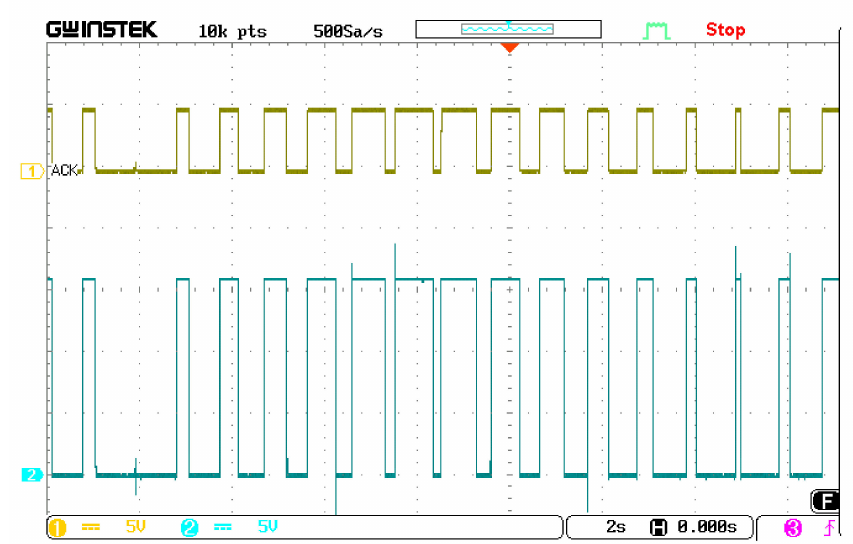
Figure 3. (Cha-1) The PWM digital output, and (Cha-2) the translated signal by the level shifter board. To mount the encoder on the motor, a 3D printed coupling was designed in the SOLIDWORKS “2020, Wyman Street, Waltham, MA, USA” platform and a frame was used to hold the encoder on the motor. The coupling and the holder were printed in the lab. Then, the encoder was coupled to the motor by the coupling and held by the holder, as shown in Figure